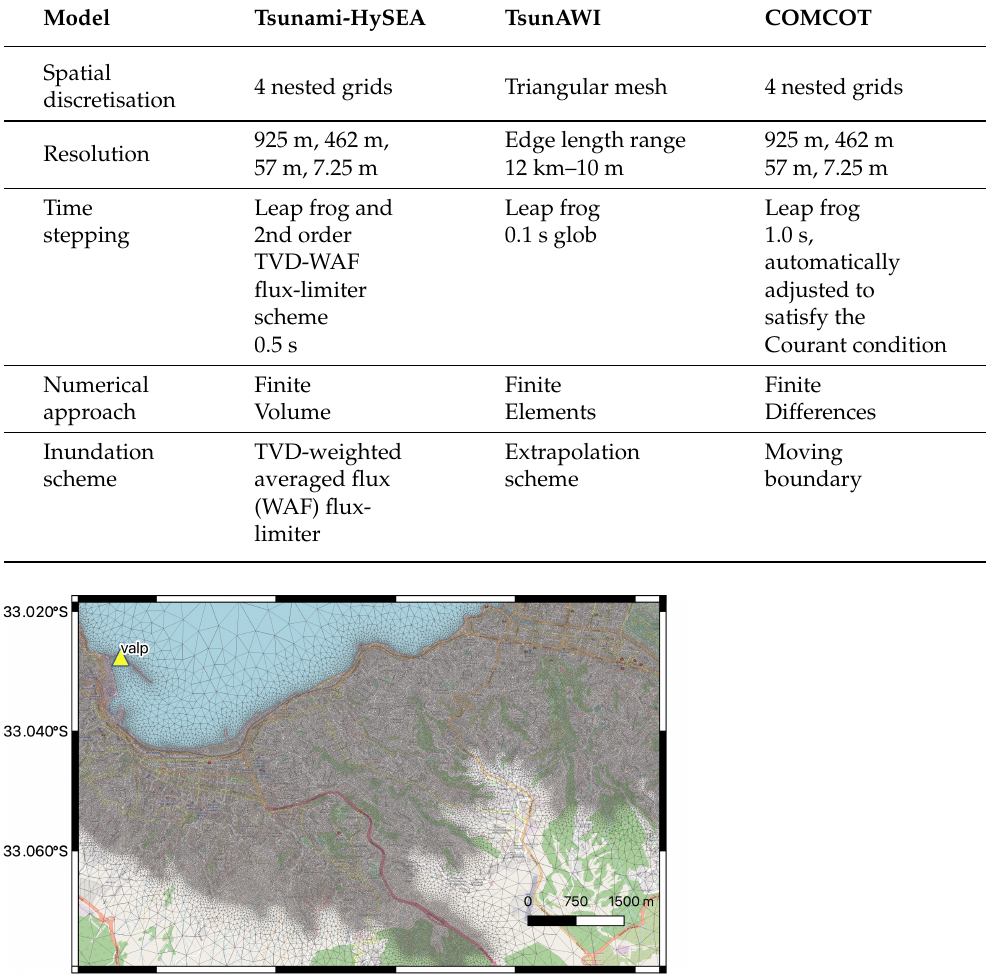
Table 1. Set-up for numerical simulations.